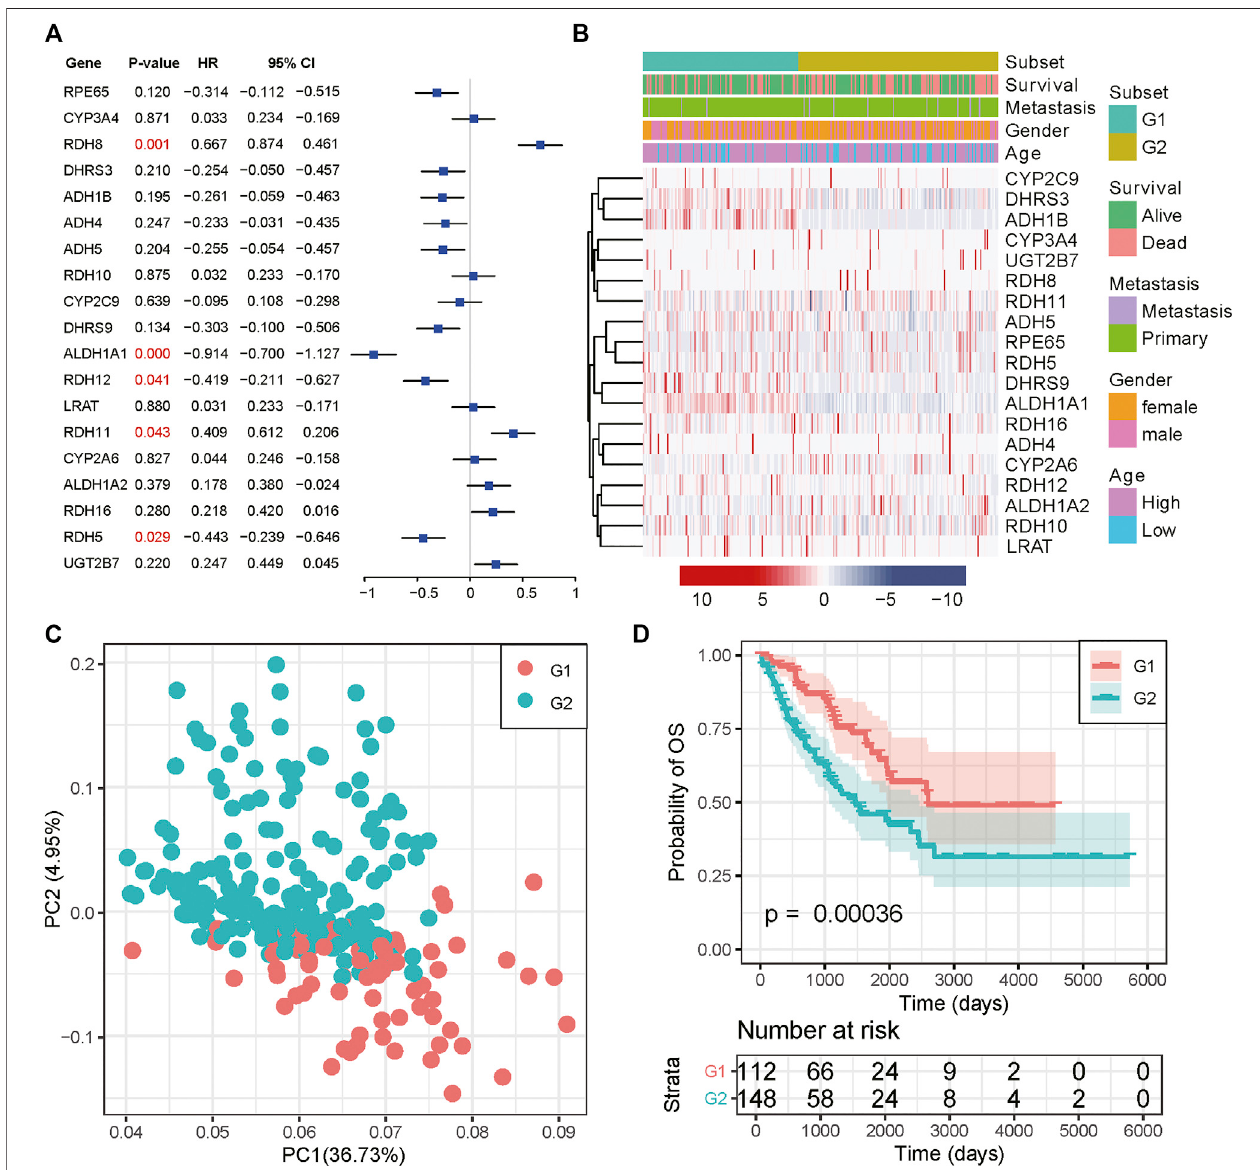
FIGURE 2 | Consensus cluster of SARC samples. (A) Forest plot of the RA metabolism-related enzymes. (B) Heatmap and clinicopathologic features of the two clusters (G1/2) de fi ned by the RA metabolism-related enzymes consensus expression. (C) Principal component analysis of the total mRNA expression pro fi le in the TCGA dataset. (D) Kaplan – Meier OS curves for different